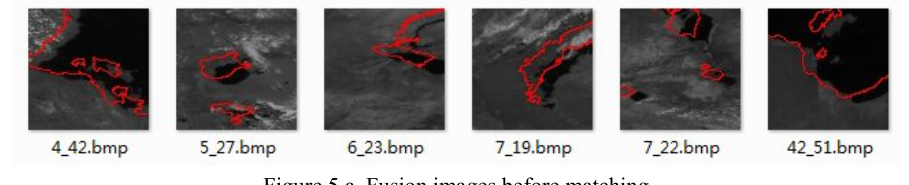
Figure 5.a. Fusion images before matching